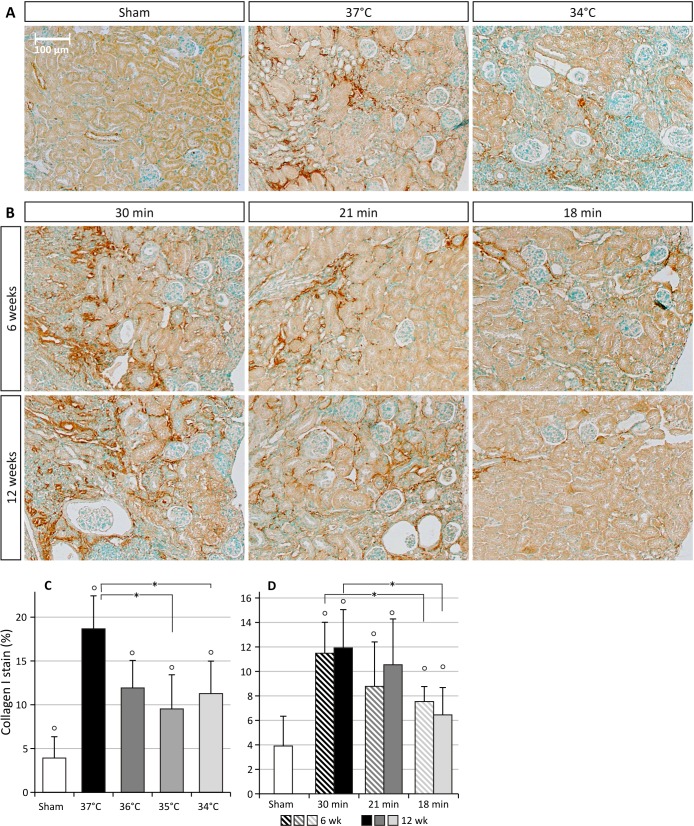
Collagen I immunostaining in the ischemic kidneys.*: p<0.05, °: p<0.05 vs. Sham. A: Effect of body temperature on long-term collagen I deposition in the ischemic kidney, 12 weeks after UIRI (magnification: 100x). B: Effect of ischemia time on long-term collagen I deposition in the ischemic kidney, 6 and 12 weeks after UIRI (magnification: 100x). C: UIRI was performed for 30 minutes at 37°C (n = 5), 36°C (n = 4), 35°C (n = 10) or 34°C (n = 5) and animals were euthanized 12 weeks after UIRI. Collagen I deposition seems to be dependent on body temperature during ischemia: more collagen I deposition after UIRI at higher body temperatures. D: UIRI was performed for 30, 21 or 18 minutes at 36°C and animals were euthanized 6 weeks (resp. n = 5, n = 12, n = 6) and 12 weeks (resp. n = 4, n = 5, n = 10) after UIRI. Collagen I deposition seems to be ischemia time-dependent: more collagen I deposition after longer ischemia times. The bars are the means ± s.d. The data were analysed using a two-tailed Mann-Whitney U test.